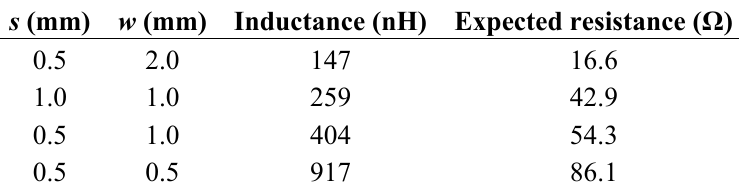
Table 1. Simulation results for different inductor designs.